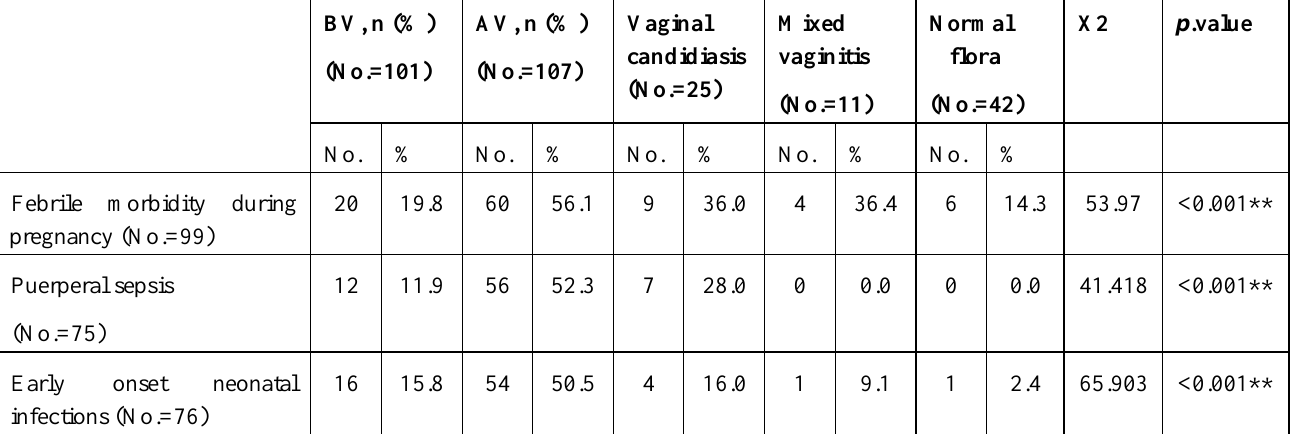
Table 5. Maternal and neonatal infectious complications in PPROM